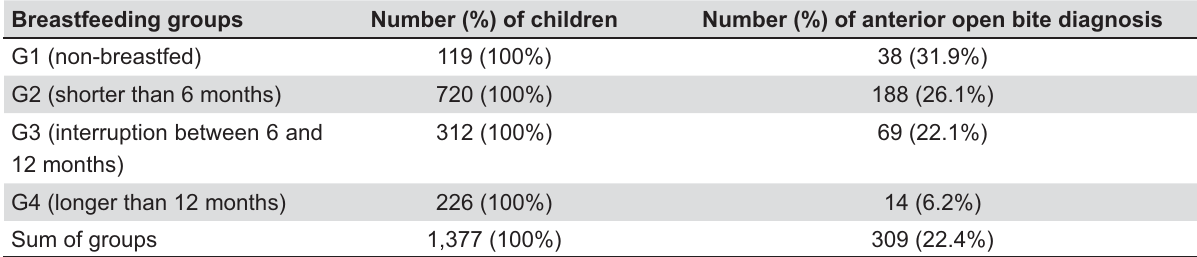
Table 1- Prevalence of anterior open bite according to breastfeeding duration in the total sample